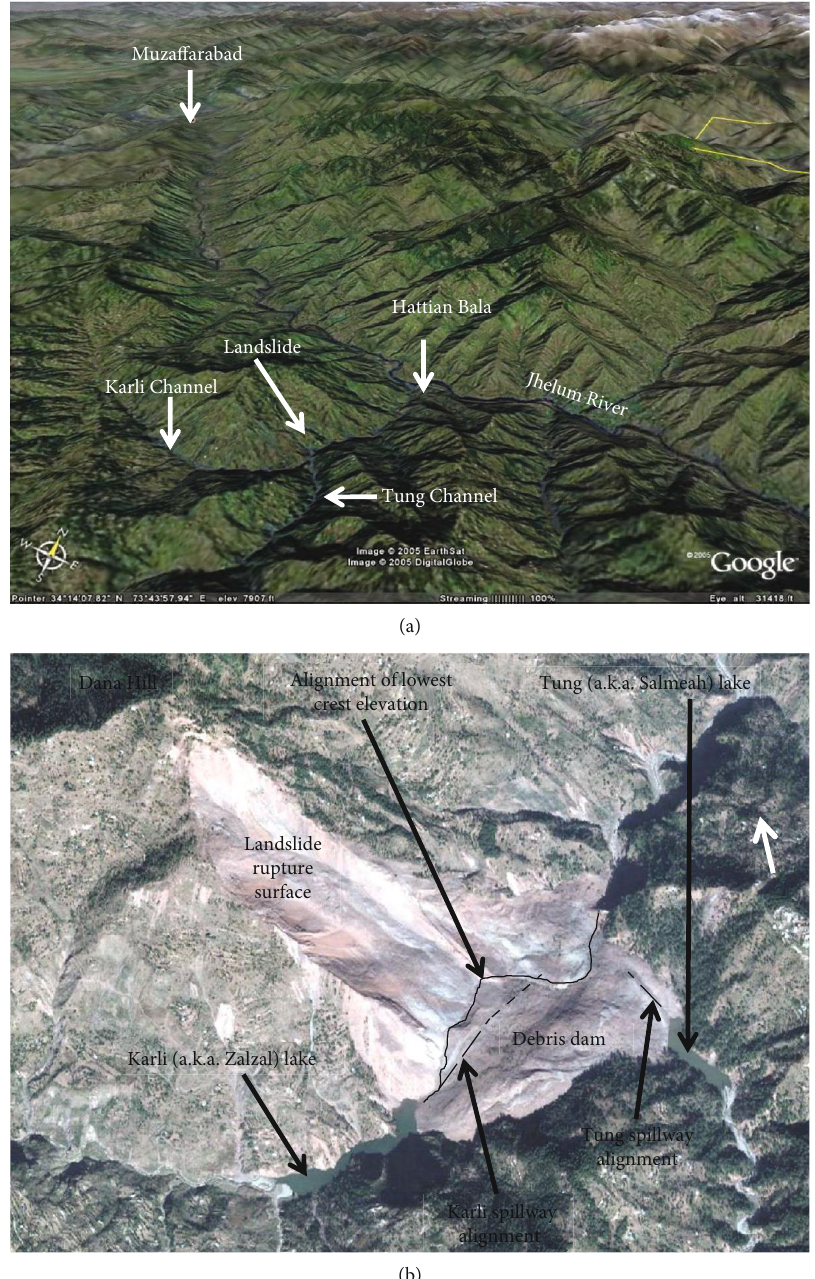
Figure 2: (a) 3D view of Hattian Bala landslide and surrounding area [7]; (b) satellite imagery of Hattian Bala landslide, dam, and lakes